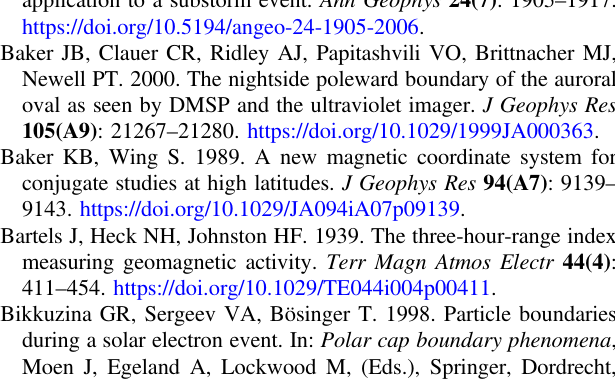
Table S1 : Magnetic apex latitude and MLT of the polar par- ticle fl ux distribution area equatorial boundary for low energy Table S2 : Magnetic apex latitude and MLT of the polar par- ticle fl ux distribution area equatorial boundary for high energy electrons and low energy protons. Table S3 : Magnetic apex latitude and MLT of the polar par- ticle fl ux distribution area equatorial boundary for high